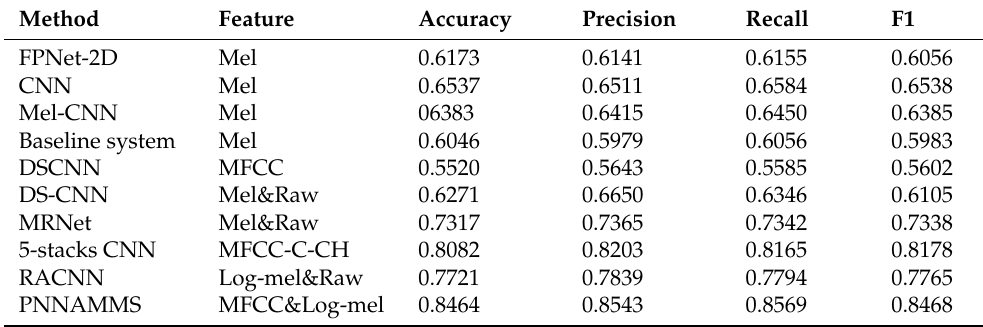
Table 3. Performance (Accuracy, Precision, Recall, and F1) of different methods on the RA_XZ dataset.